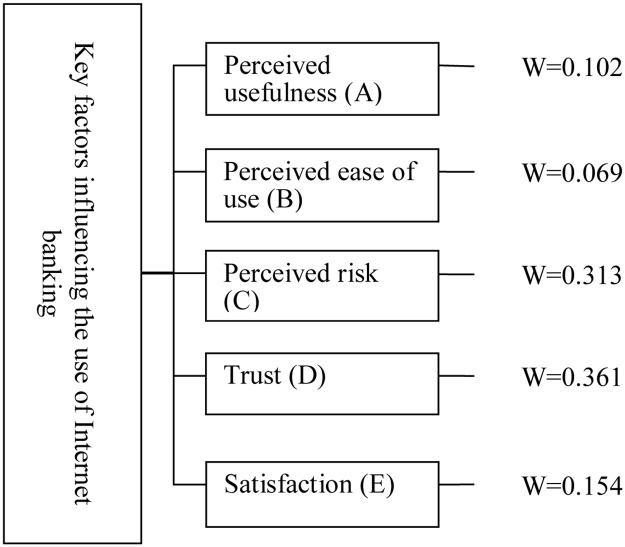
Weight of factors.